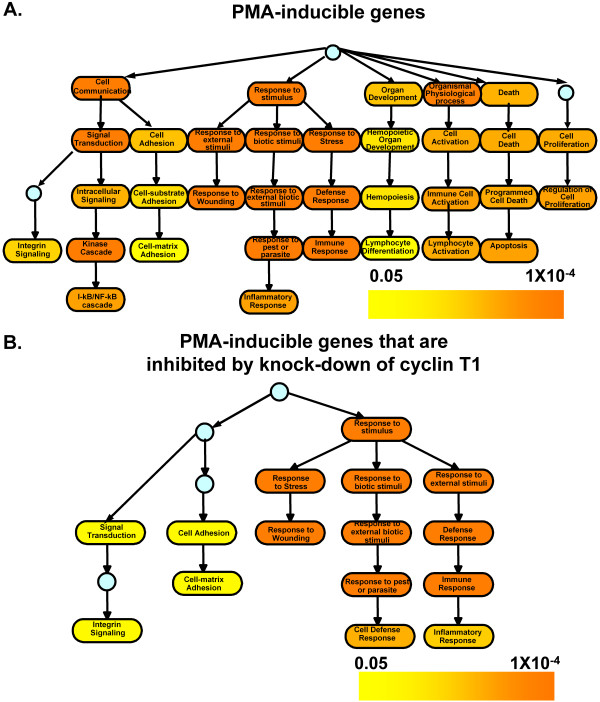
Gene Ontology analysis. GO content analysis was performed by tabulating the various gene lists against the GO structure. (A) Biological processes that were over-represented in the PMA-inducible genes compared to a random list of the same size. The color of each GO term was assigned corresponding to its adjusted P-value, while color intensity representing the adjusted P-value is indicated by color scaling. (B) Similar analysis was performed on genes induced by PMA and repressed by shRNA-T1. The color of each GO term was assigned corresponding to its adjusted P-value, while color intensity representing the adjusted P-value is indicated by color scaling.